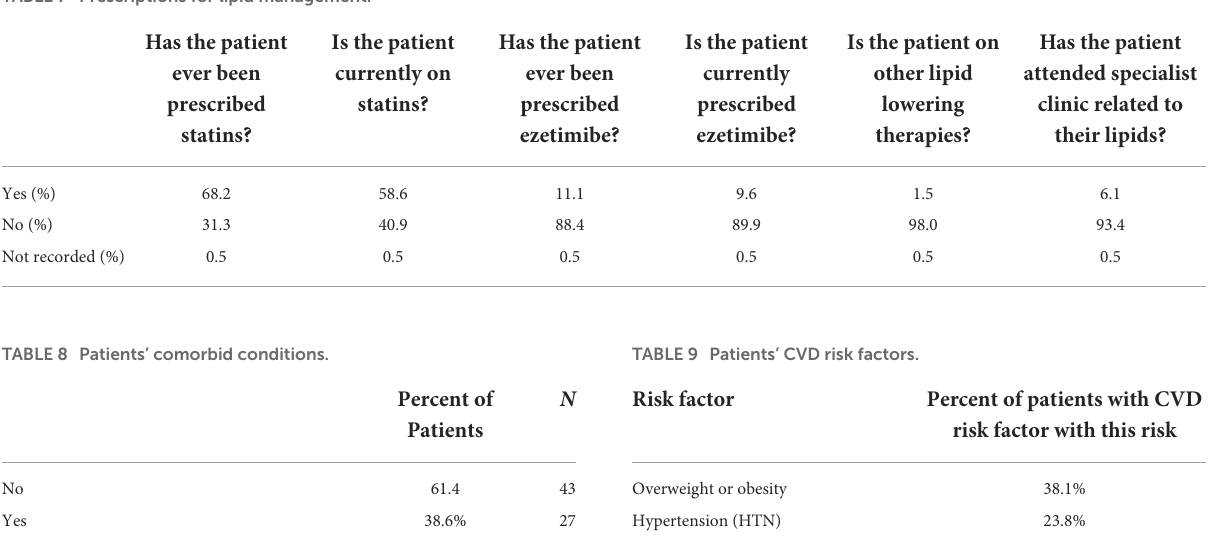
TABLE 7 Prescriptions for lipid management.